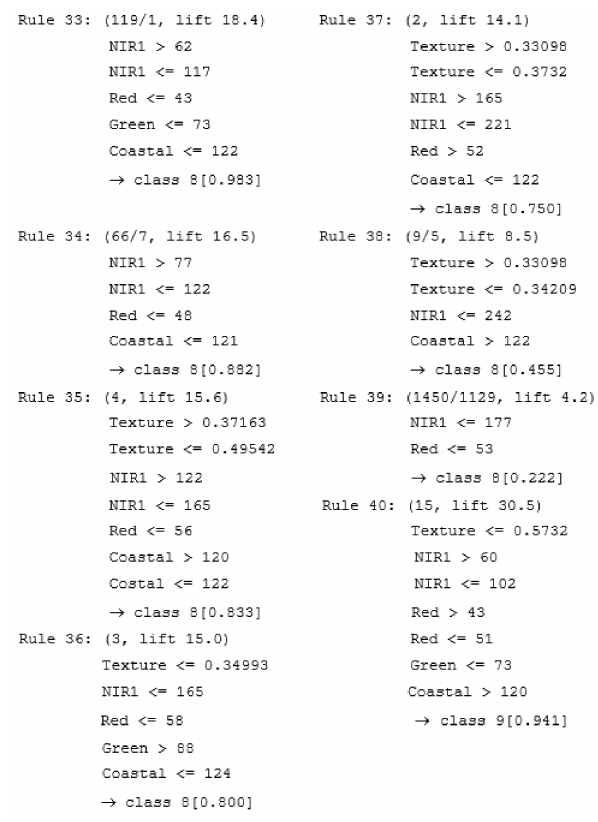
Figure 4. An example of the rule-based approach for classifying the Selenga River Delta